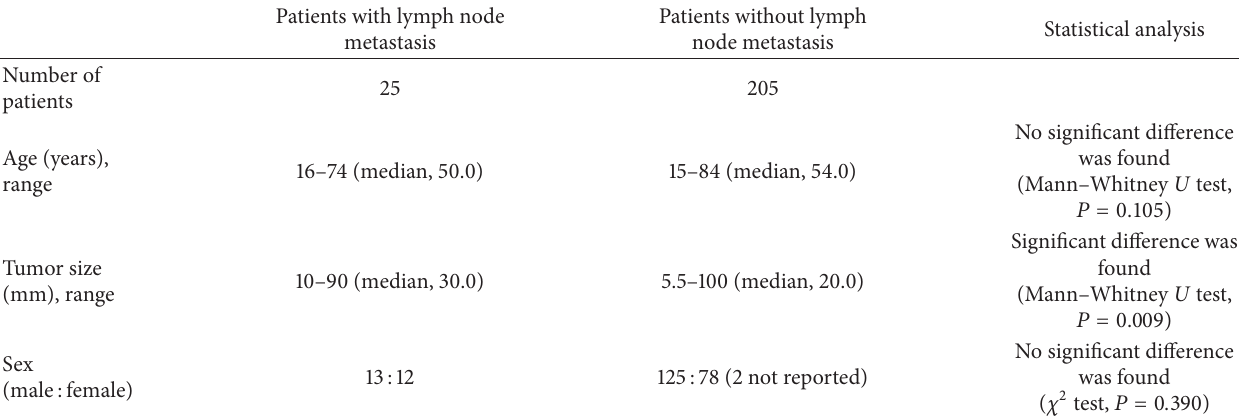
Table 2: Comparison of clinicopathological data between patients with and those without lymph node